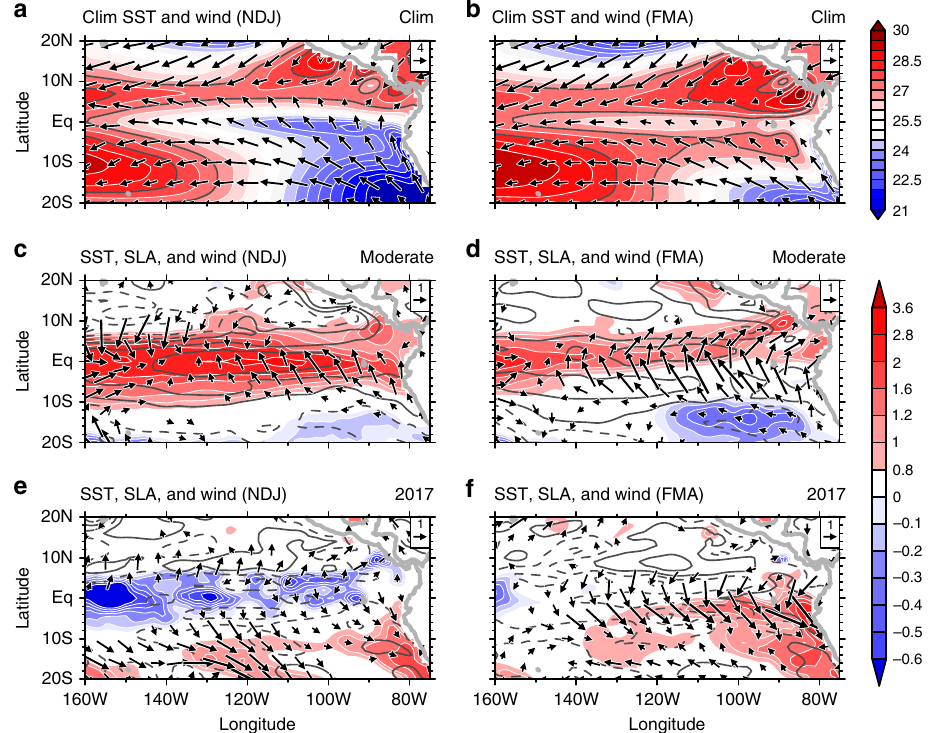
Fig. 8 Ocean – atmospheric conditions of basin-scale moderate El Niño and the 2017 extreme coastal El Niño. Climatological SST (°C; color shading; 27 and 28 °C contours in gray line) and winds (vectors; m s − 1 ) over the eastern Paci fi c for a NDJ and b FMA; composite NDJ (left) and FMA (right) SSTAs (°C; color shading), SLA (contours with an interval of 2 cm, zero omitted and negative dashed) and wind anomalies (m s − 1 ; arrows) for basin-scale moderate El Niño ( c , d ) and the 2017 extreme coastal El Niño ( e , f )